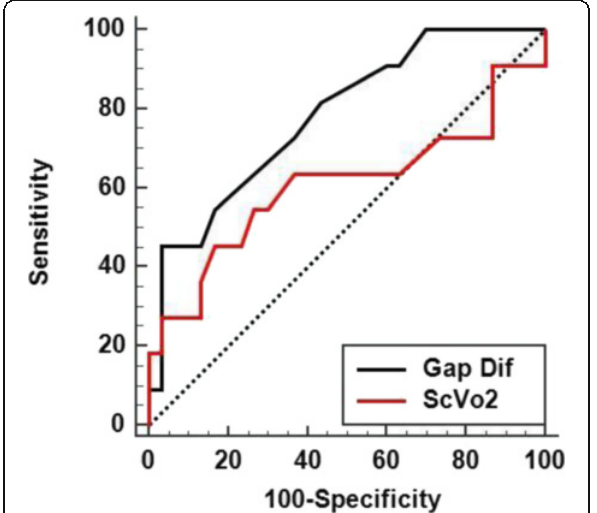
Fig. 74 (abstract A168). AUROC for Co2 Gap and ScVo2 to predict